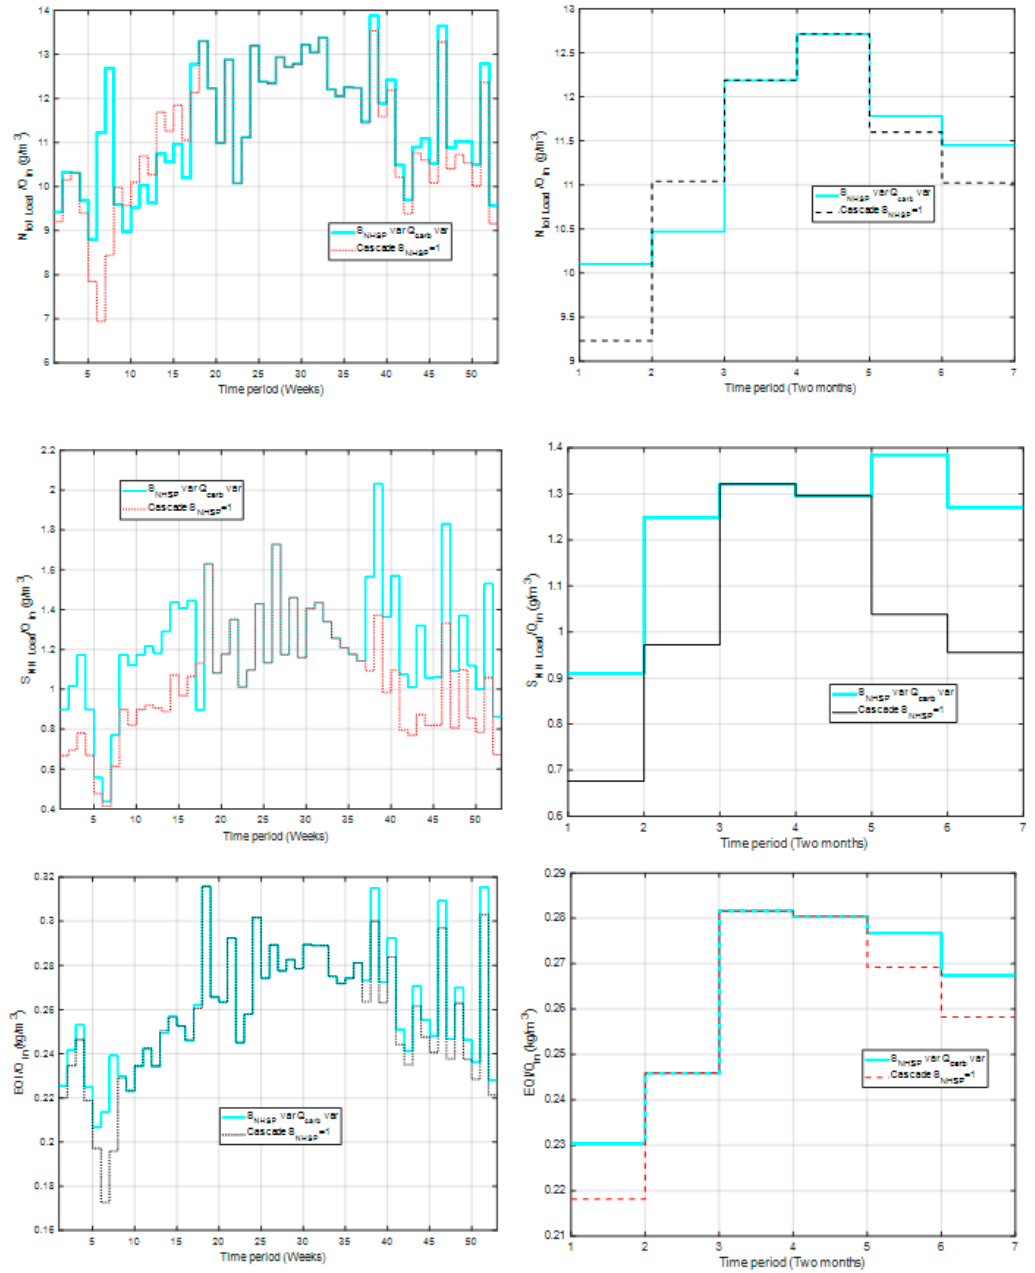
Figure 14. Weekly and bimonthly profile for emissions to water indicators N tot Load / Q in (g / m 3 ), S NH Load / Q in (g / m 3 ) and EQI / Q in (kg / m 3 ) with Cascade S NHSP and the alternative strategy. Table 13. Annual values of environmental indicators and operating costs of BSM2 plant with respect to the volume of treated wastewater with the Cascade S NHSP and proposed alternative strategies.